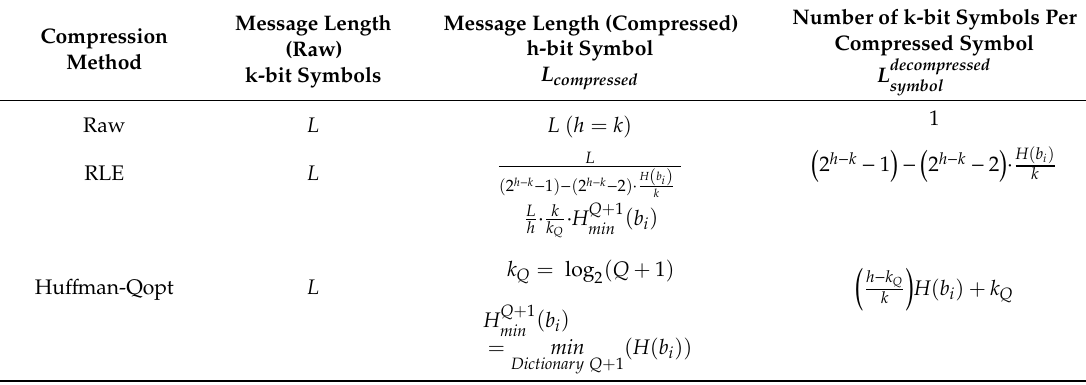
Table 5. Query process cost for di ff erent endpoint’s